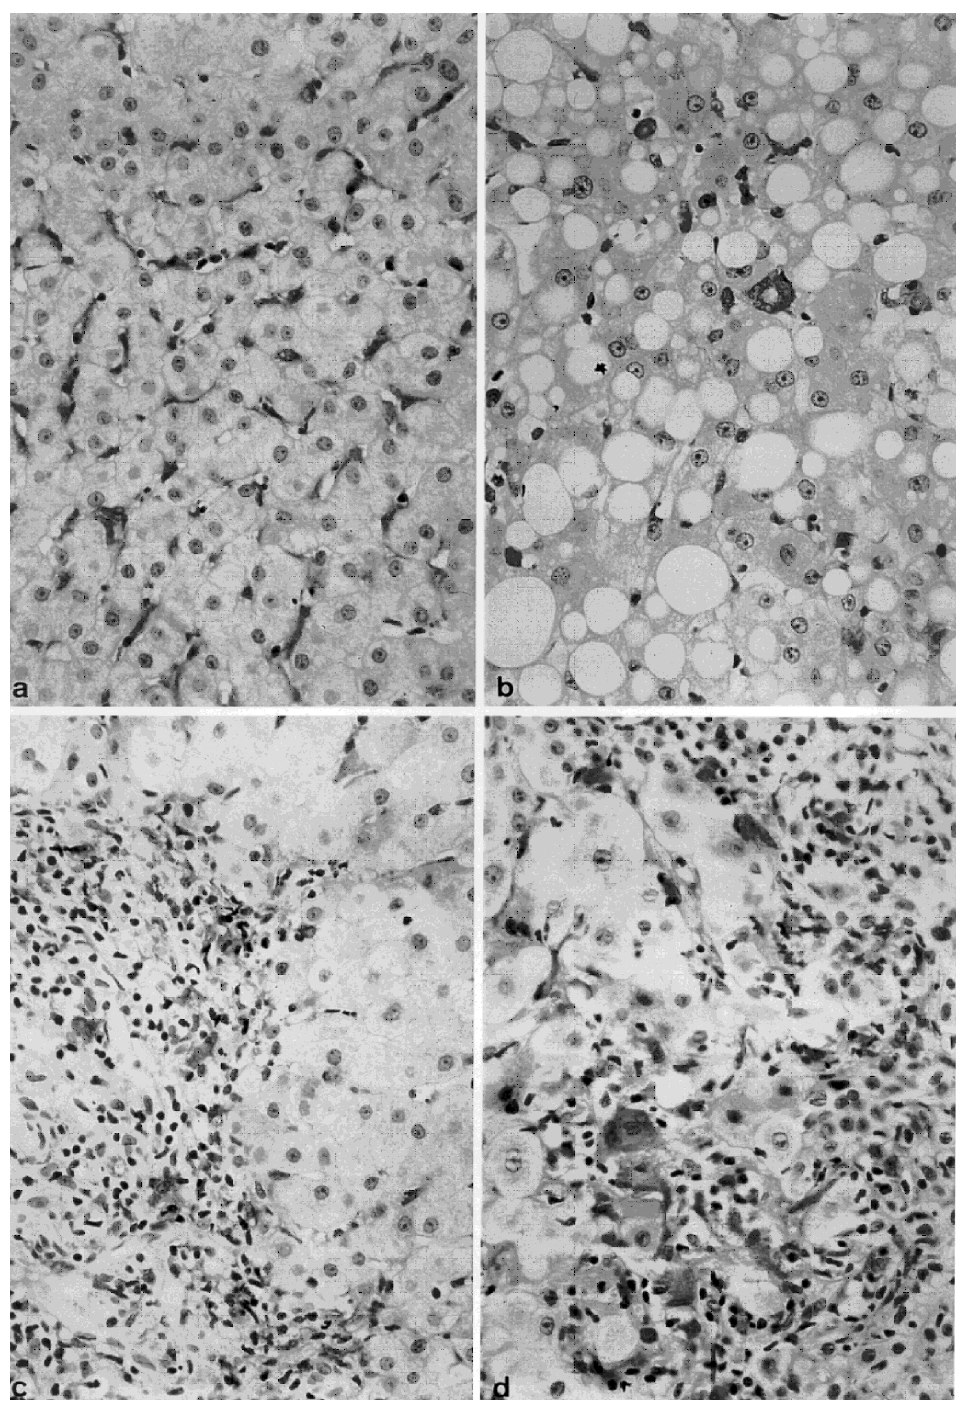
Fig. 1. PG-M1 staining of normal (a) and fatty (b) liver reveals macrophages in the pericentral fields. In hepatitis B with moderate (c) and severe (d) inflammation, the number of macrophages is markedly elevated. Original magnification ×